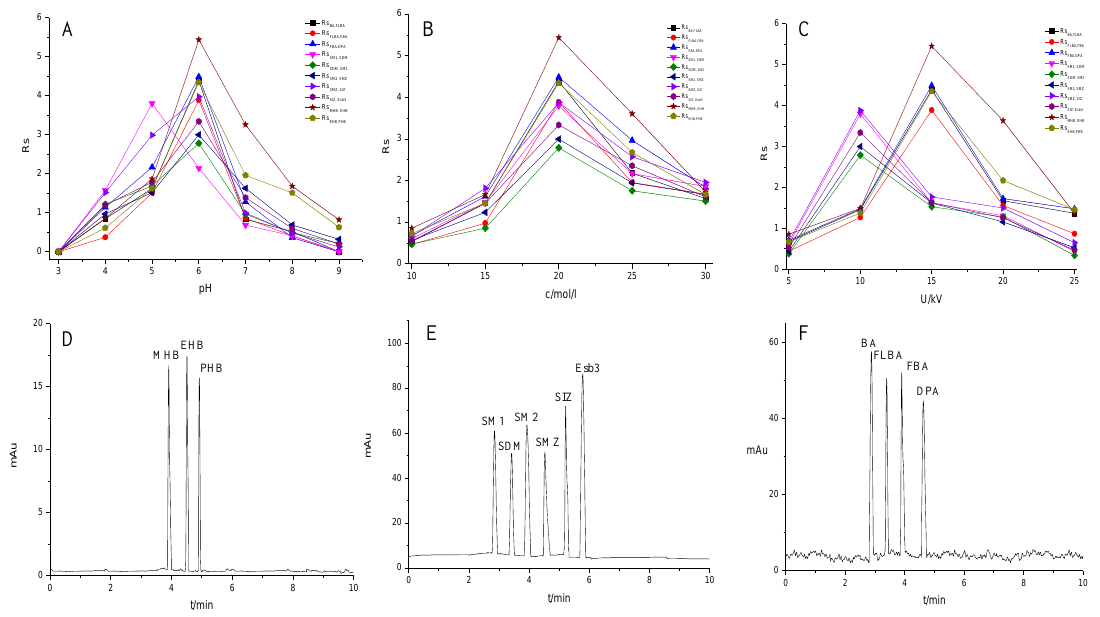
Figure 8. Effect of experimental conditions on the separation of the small molecular compounds. ( A ) pH, ( B ) buffer concentration, ( C ) operating voltage and separation chromatograms for the analytes on the TpBD COF immobilized capillary: ( D ) parabens, ( E ) sulfonamides and ( F ) benzoic acids. Experimental conditions: temperature, 20 °C. The pH of buffer solutions is a crucial parameter in CEC, which may influence the separation of the analytes through altering the mobility of charged analytes and the mag- nitude of EOF. The effect of buffer pH on separation was studied over the range from 3.0